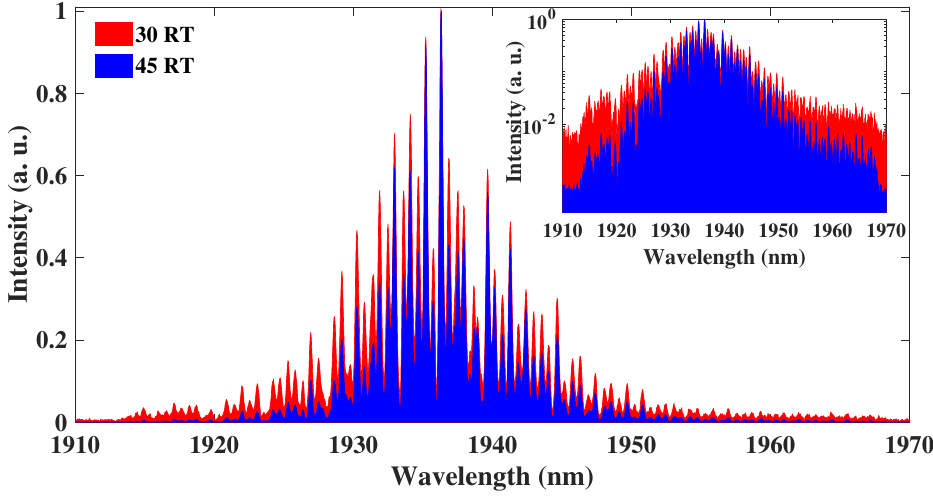
Figure 6. Comparison between the pump pulses after 45 and 30 round trips (RT). Inset: intensity representation in logarithmic